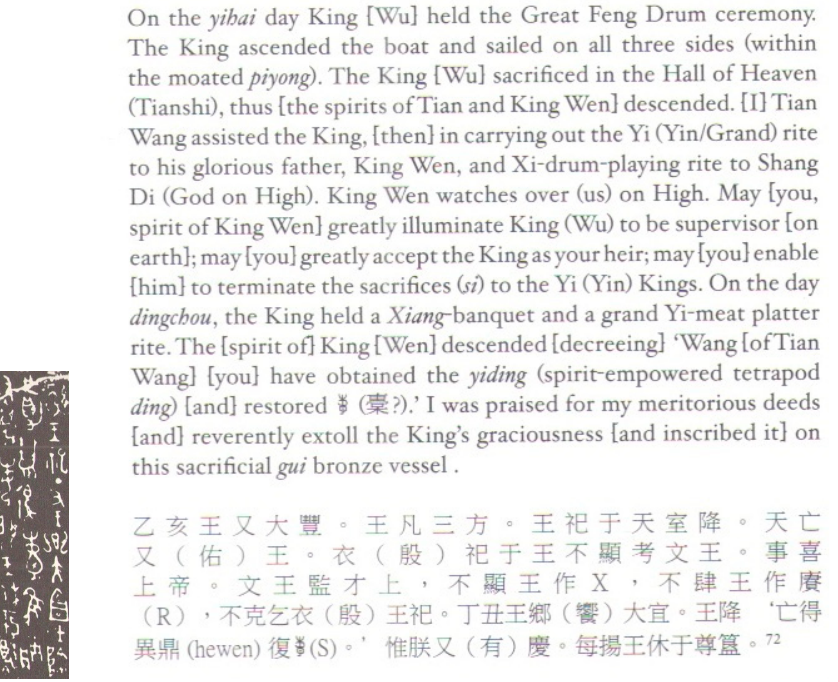
Figure 1. Masked semi-human figures with arms raised. ( A ) Yi 異 graph; ( B ) Displayed yi image, probably Kui; ( C ) Simplified displayed yi image. The significance of these yi or metamorphic power images is directly allied with the king’s cosmological power to rule, as revealed in a related term, yiding ( 異鼎 ), the hewen (two graphs joined into one graph) known in a variety of early inscriptional contexts including Shang and pre- conquest Western Zhou divinatory inscriptions and Western Zhou bronze vessel inscriptions. As will be analyzed below, these inscriptional contexts corroborate that yiding refers specifically to the tetrapod fangding, and secondly to a fangding with yi spirit power, the basis of a king’s power to rule in Shang time and apparently also in Western Zhou time. The types of data that exhibit a continuation of Shang belief in these symbolic attributes are both archaeological and paleographic, depending on extant or excavated fangding and their inscriptions. As will become clear, royal fangding and yiding were one and the same vessel.